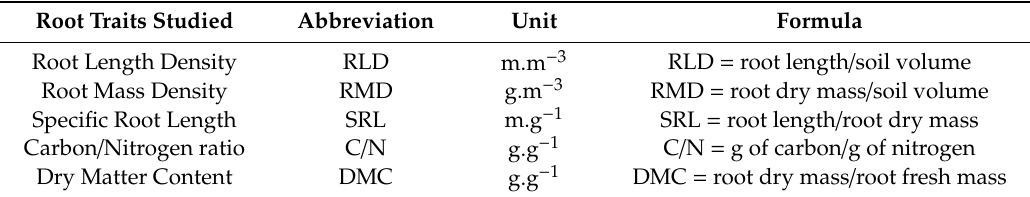
Table 1. List of measured traits, their abbreviations, units and the formula used. Root Traits